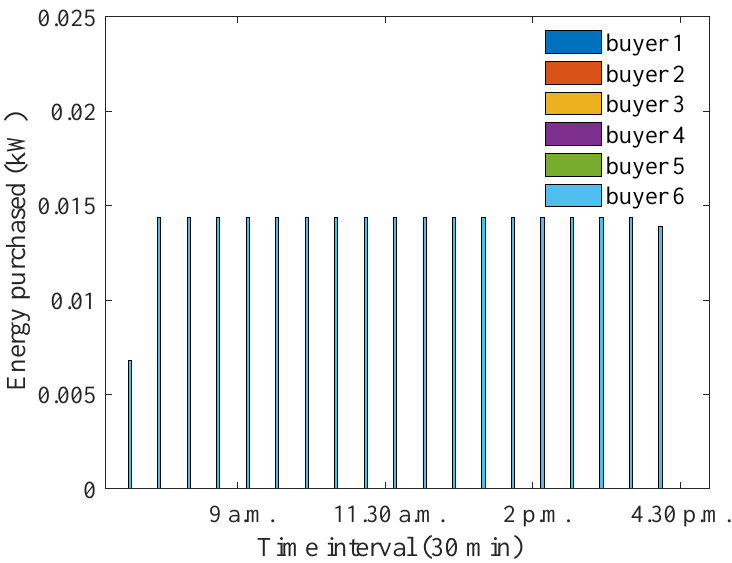
Figure 14. Optimum energy purchased for equally preferred sellers and buyers during summer